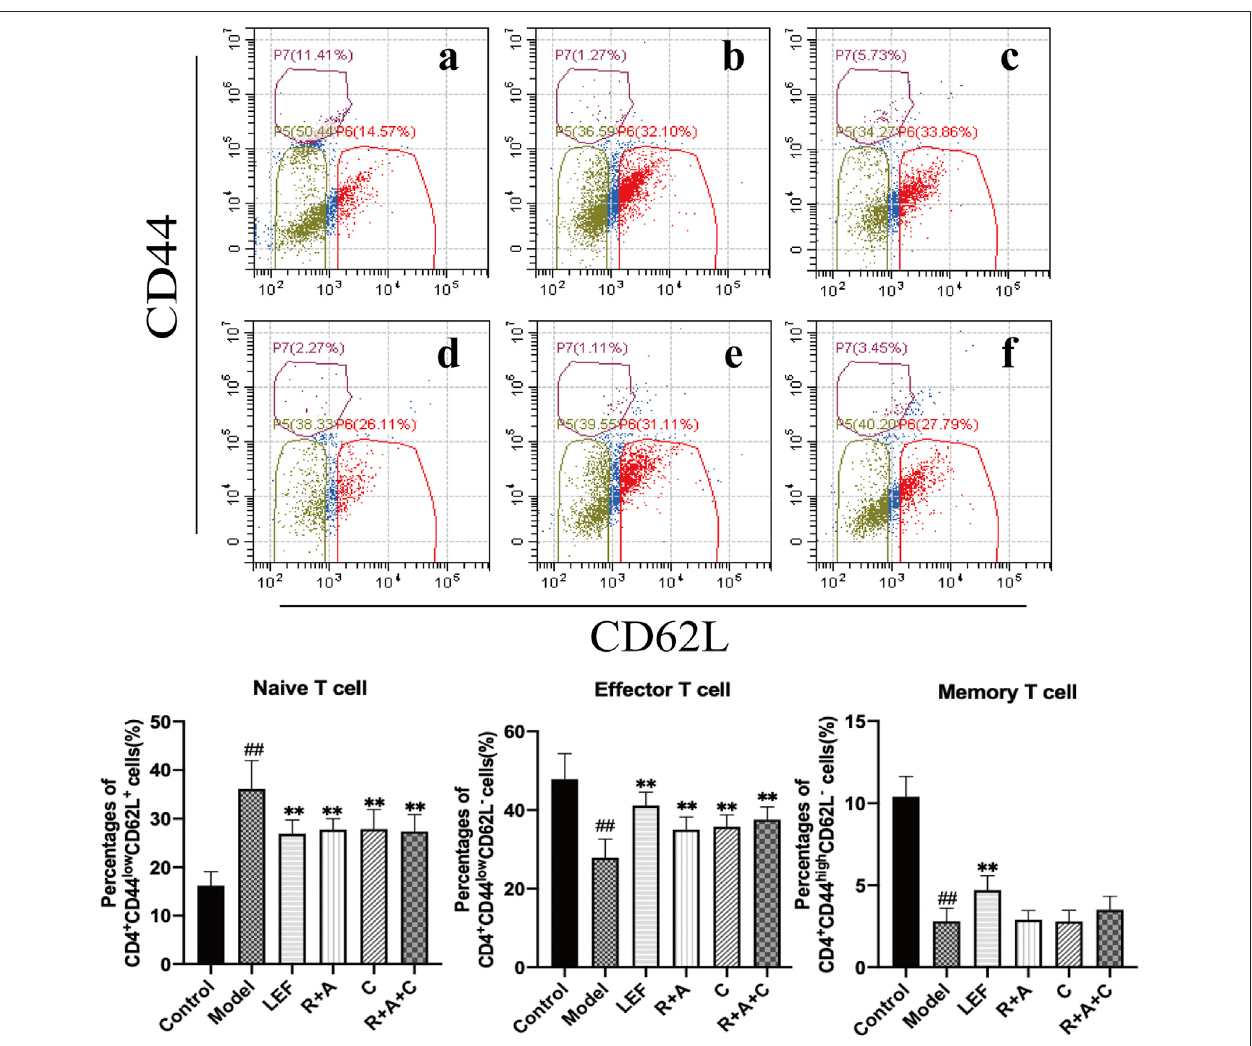
FIGURE 4 | The percentages of CD4 + CD44 High CD62L − T-cells, CD4 + CD44 Low CD62L − T-cells and CD4 + CD44 Low CD62L + T-cells. (a) , control group; (b) , model group; (c) ,LEFgroup; (d) , R . astragali + R . angelicaesinensis (R+A)group; (e) , C . lonicerae (C)group;and (f) , R . astragali + R . angelicaesinensis + C . lonicerae (R+A+ C) group. Results are presented in a bar chart. Data are presented as mean ± SD ( n = 8); # p < 0.05, ## p < 0.01, compared with the normal group; * p < 0.05, ** p < 0.01, compared with the model